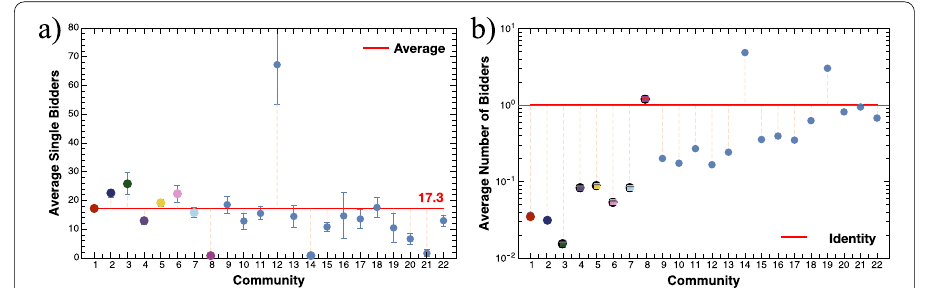
Fig. 5 Characterization by bidding activity. Panel a shows the average number of single bids per community (i.e., the average number of times a firm in a community participated in a tender as the single bidder). We compared the values of each company with the average of the entire population of firms (horizontal red line). Panel b shows the average number of bidders in tenders in which firms within a community typically participate. We normalized the value obtained for each community by the number of firms in that community. The horizontal red line shows the threshold that marks the size of the